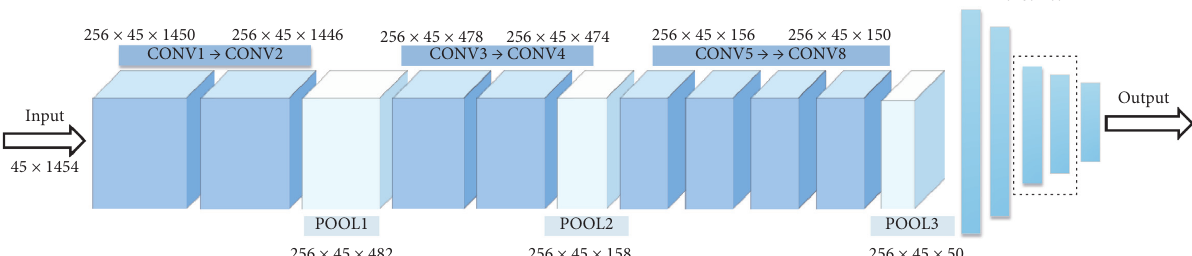
Figure 2: The structure diagram of the convolutional neural network.